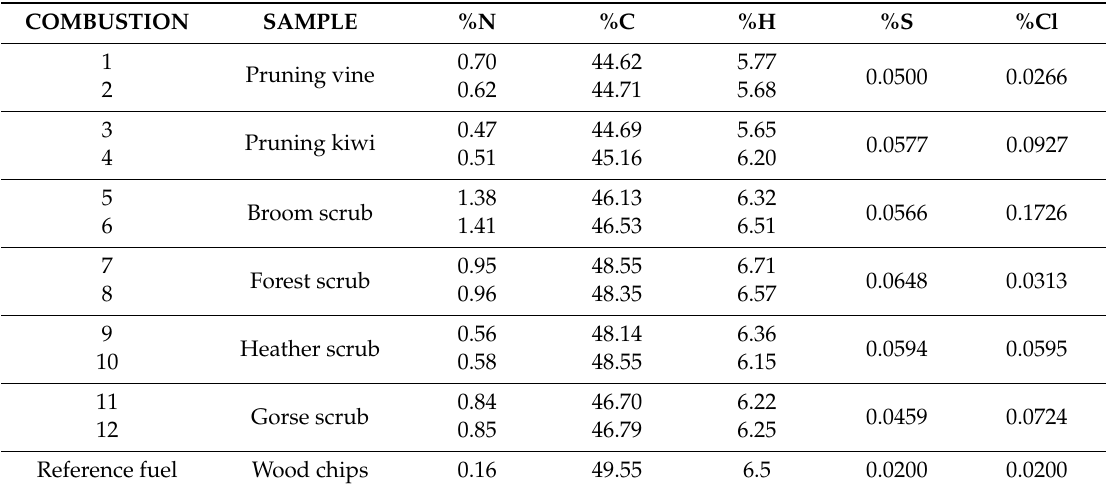
Table 3. Ultimate analyses of biomasses studied.